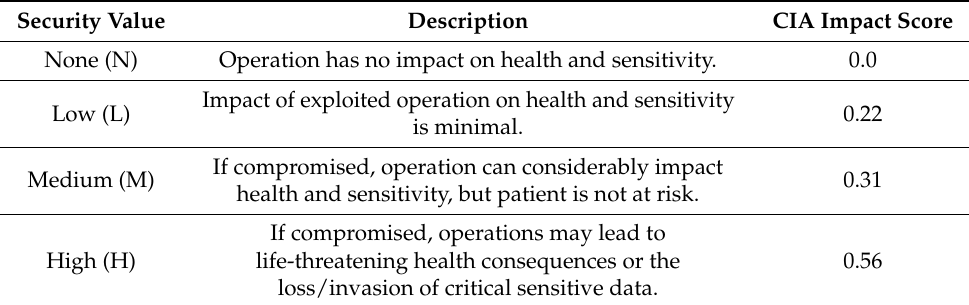
Table 1. Health and data sensitivity impact scoring